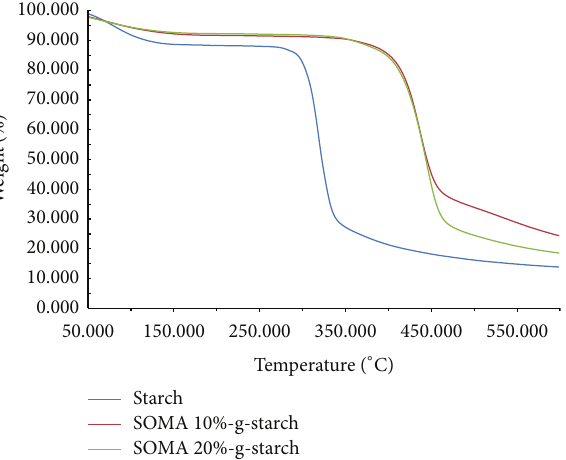
Figure 3: FTIR spectra of starch and soybean oil-g-cassava starch powder.